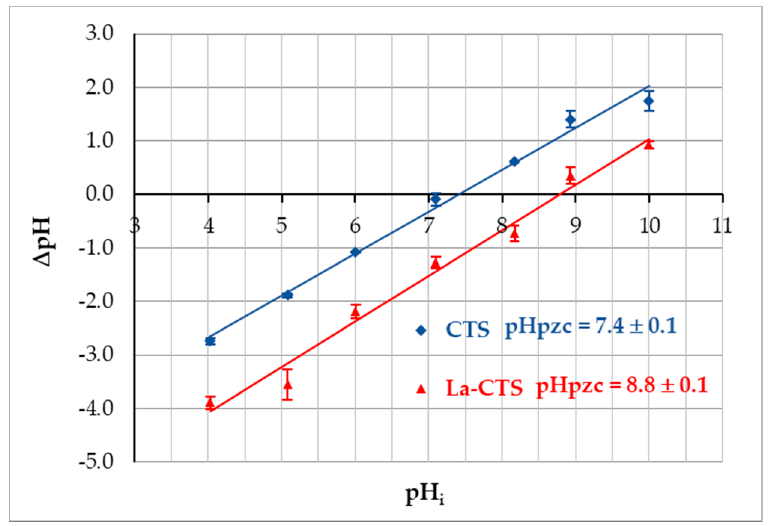
Figure 5. The pH i versus Δ pH for unmodified chitosan (CTS) and chitosan attached with lanthanum (La-CTS).